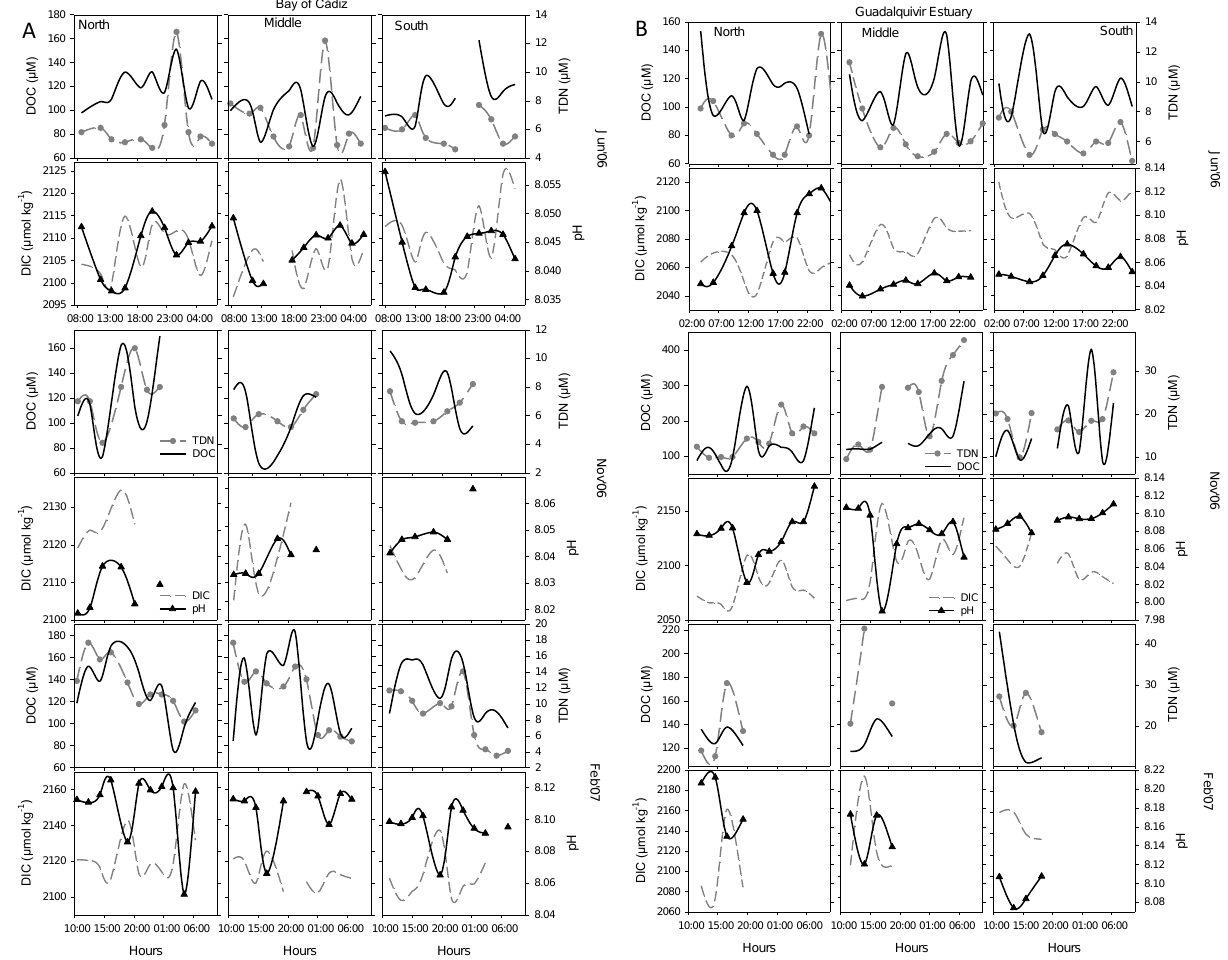
Fig. 4. Daily variations in surface seawater dissolved organic carbon (DOC) (black solid line), total dissolved nitrogen (TDN) (grey dashed line with circle), dissolved inorganic carbon (DIC) (grey dashed line) and pH (black solid line with triangles) from the transect off the Bay of C´adiz (A) and Guadalquivir estuary (B) at the three different stations (Fig.